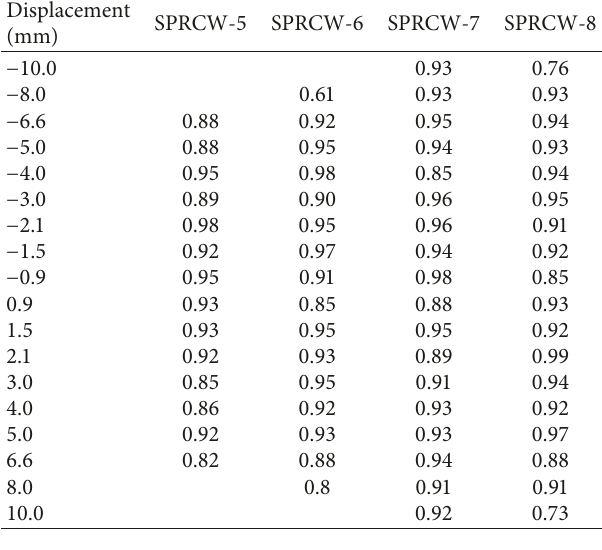
Table 6: Intensity attenuation coefficient of test pieces.